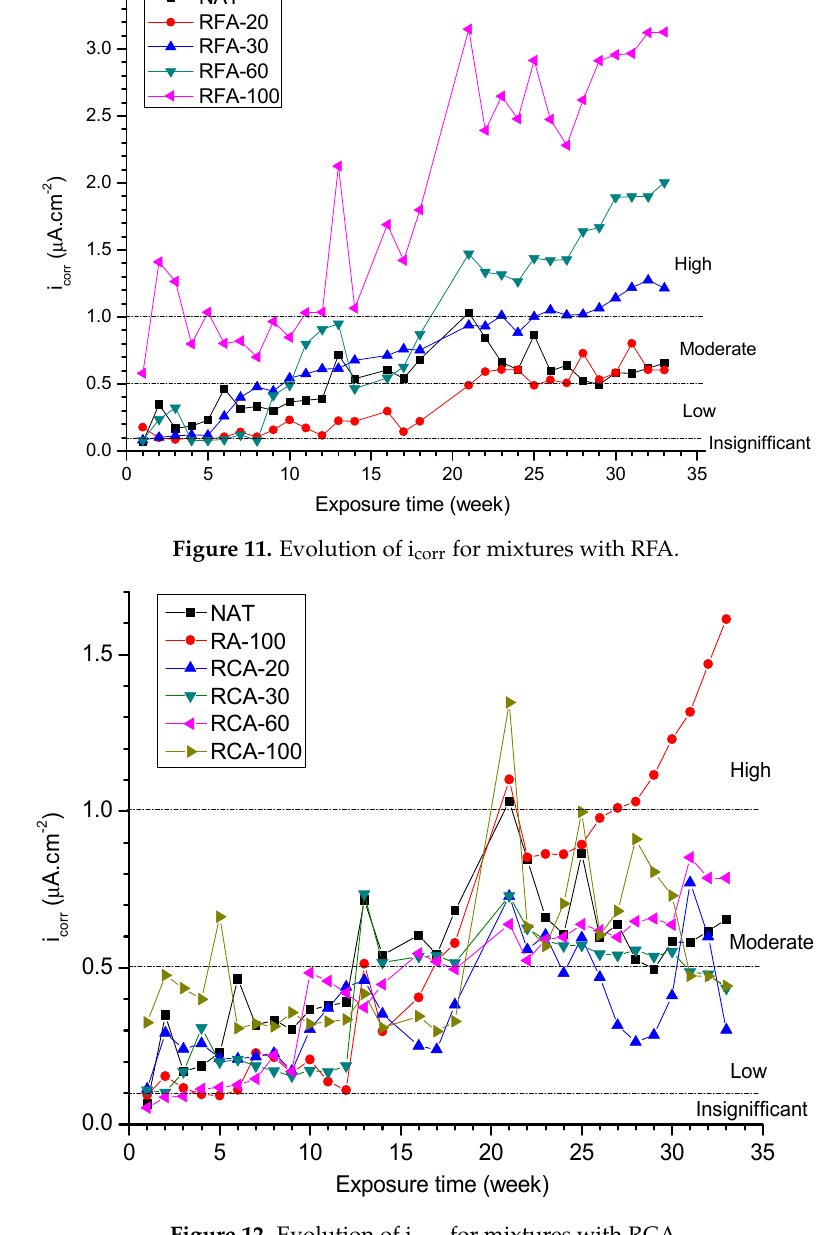
Figure 12. Evolution of i corr for mixtures with RCA.